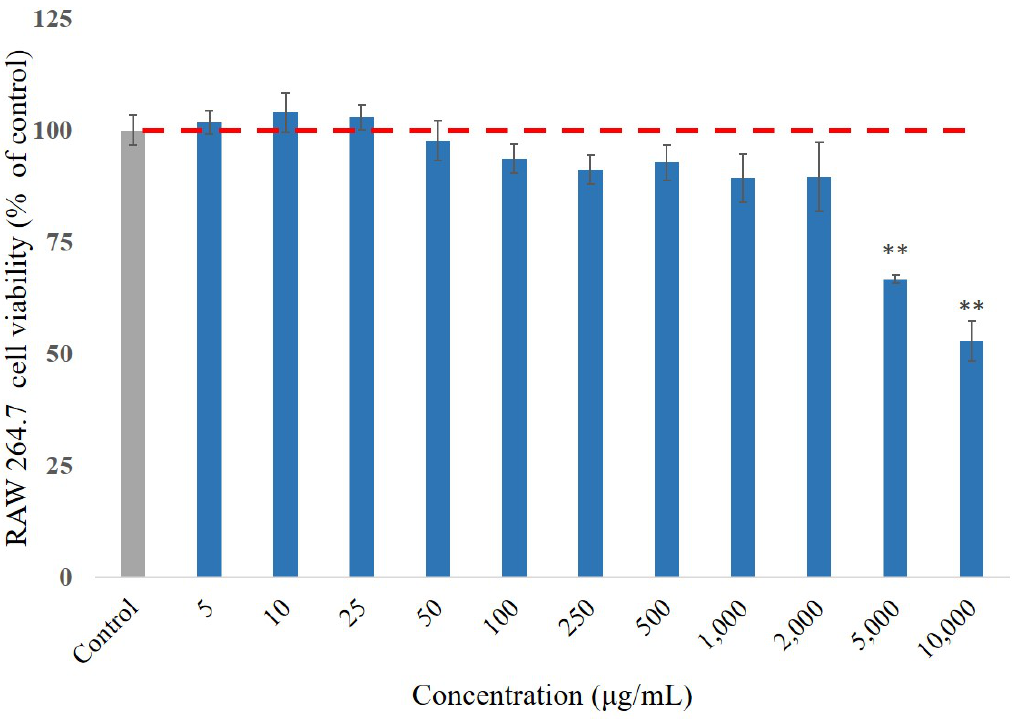
Figure 1. The cell viability of RAW 264.7 cells was measured by MTT assay after 24 h treatment of P. emblica samples. The data represented mean ± S.D. of three independent experiments performed. The red dash line is the trend line for cell survival rate of 100%. *p < 0.05, **p < 0.01.